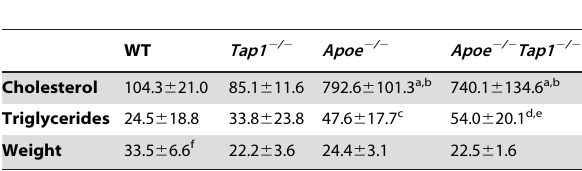
Table 2. Plasma cholesterol, triglycerides and weight at 26 weeks of